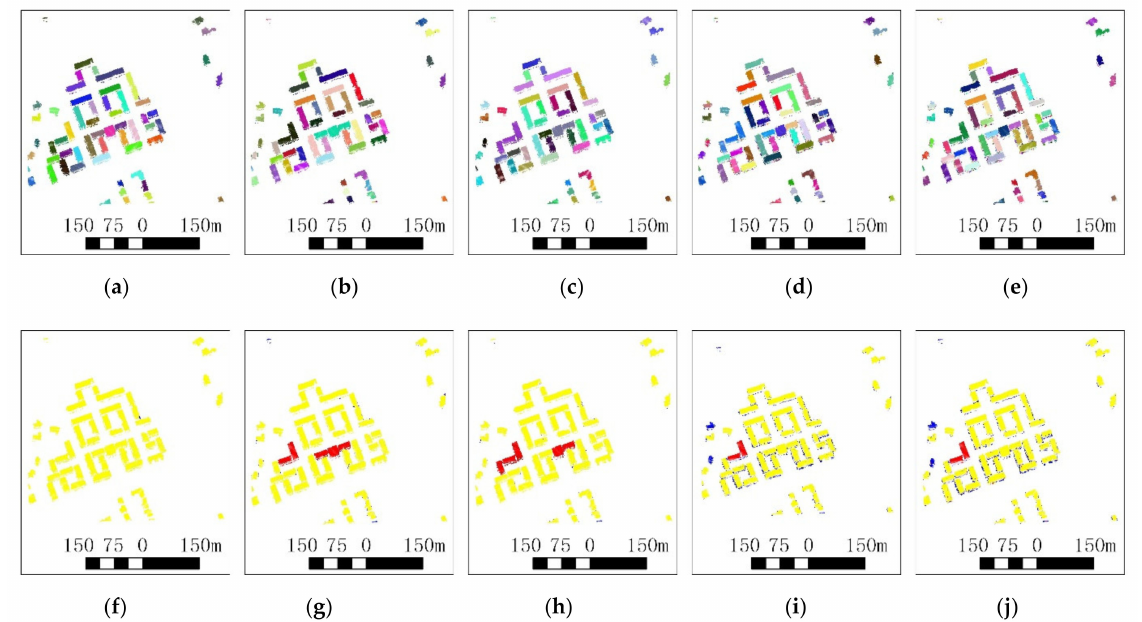
Figure 16. Building instance segmentation result comparison of dataset 4: ( a ) Result of the UBIS method; ( b ) result of the MV method; ( c ) result of the ES2D method; ( d ) result of the ES3D method; ( e ) result of the LCCP method; ( f ) the main differences between the result of the UBIS method and the ground truth; ( g ) the main differences between the result of the MV method and the ground truth; ( h ) the main differences between the result of the ES2D method and the ground truth; ( i ) the main differences between the result of the ES3D method and the ground truth; ( j ) the main differences between the result of the LCCP method and the ground truth.